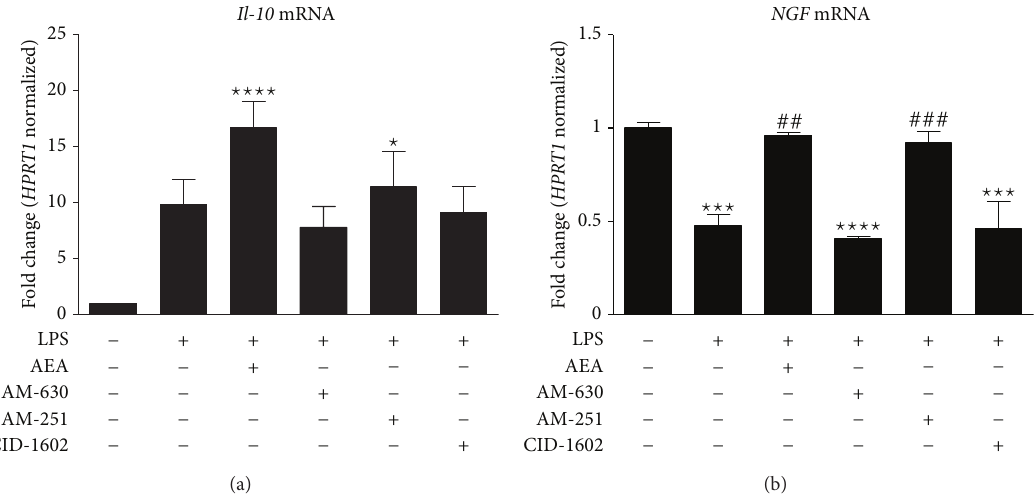
Figure5:ExpressionoftranscriptsfortheM2phenotypicmarkers Il-10 and Ngf inratprimarymicroglialculturesinthepresenceofthetested compounds. Samples were analyzed 24 hours after the stimulation of cells with LPS. Data are presented as the mean ± SEM and represent the normalized averages derived from 6 to 8 samples per group. The results are presented as fold-change normalized to the expression of the reference gene Hprt1 and were calculated relative to nonstimulated cells. Statistical analysis was performed using one-way ANOVA followed by Bonferroni post hoc tests; values with 𝑃 < 0.05 were considered significant. * It denotes a significant difference versus the nonstimulated control; #, versus the LPS-stimulated